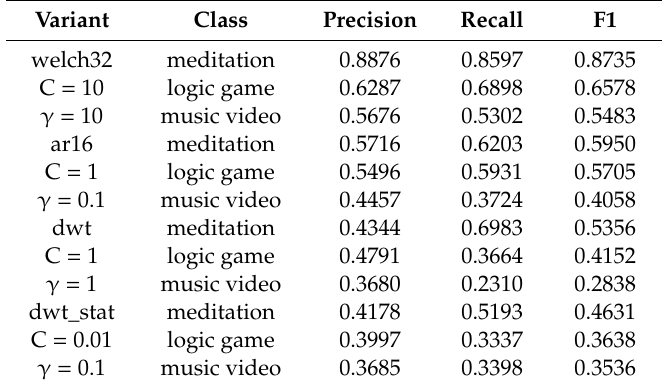
Table20. Valuesofprecision, recall, andF1scoreforeachsignalclassforchosenvariantsofExperiment3.